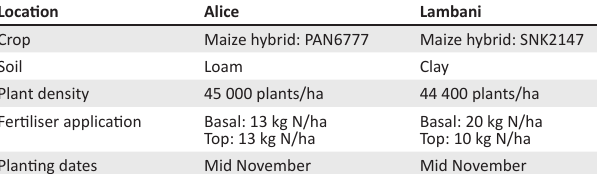
TABLE 2: Simulated biophysical conditions and agronomic management strategies.